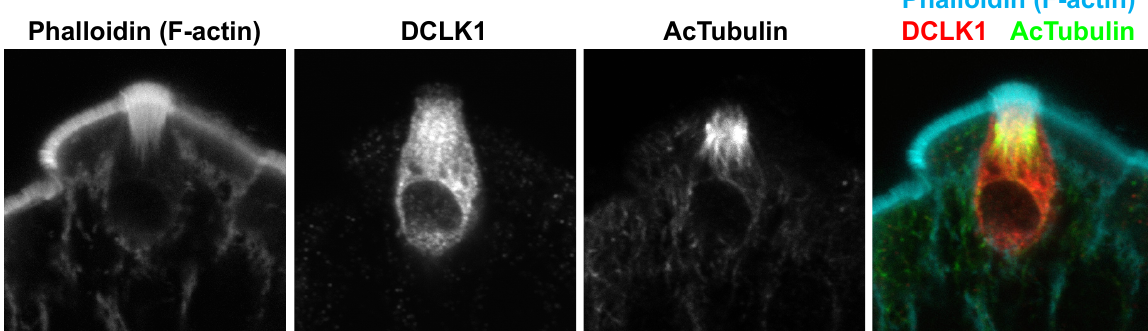
Figure 2. Tuft cell morphology in mouse small intestine. Widely used tuft cell markers, F-actin (phalloidin), DCLK1, and acetylated tubulin demonstrate the microvillus structure, whole-cell shape, and dense microtubules, respectively.